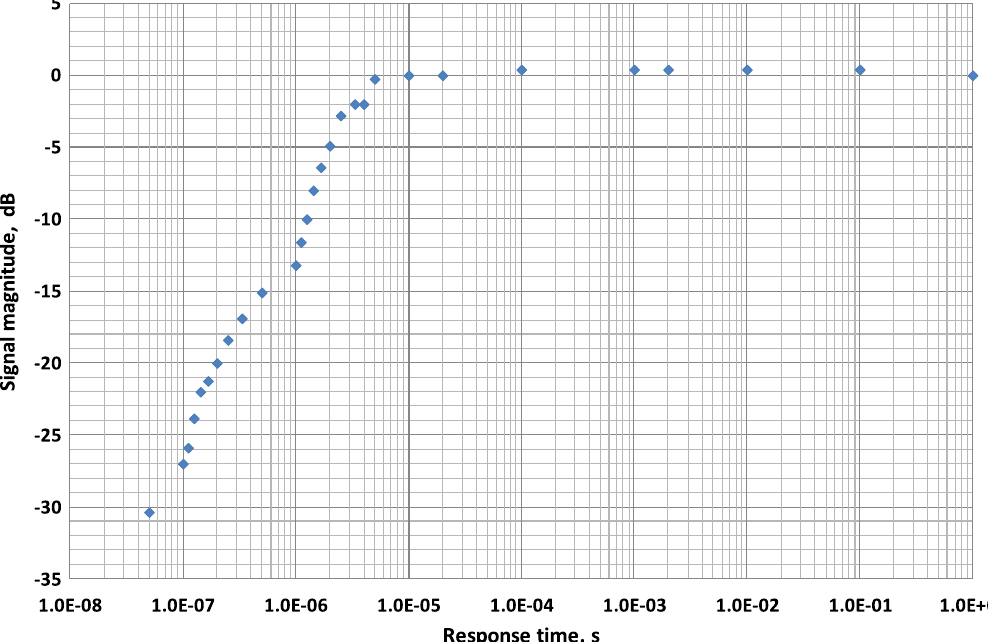
Fig. 5. Response time of the ODS as it was characterized in [8].